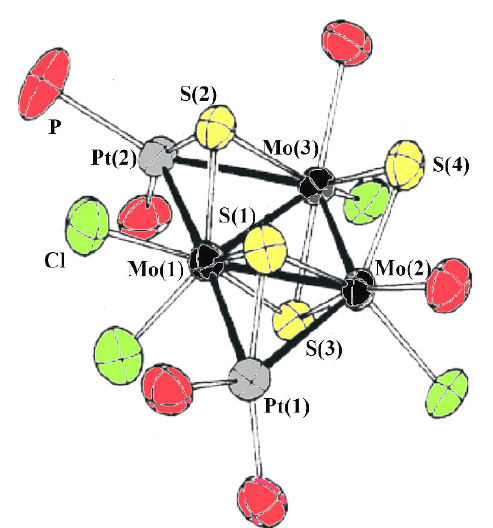
Figure 3. Structure of [{(PEt